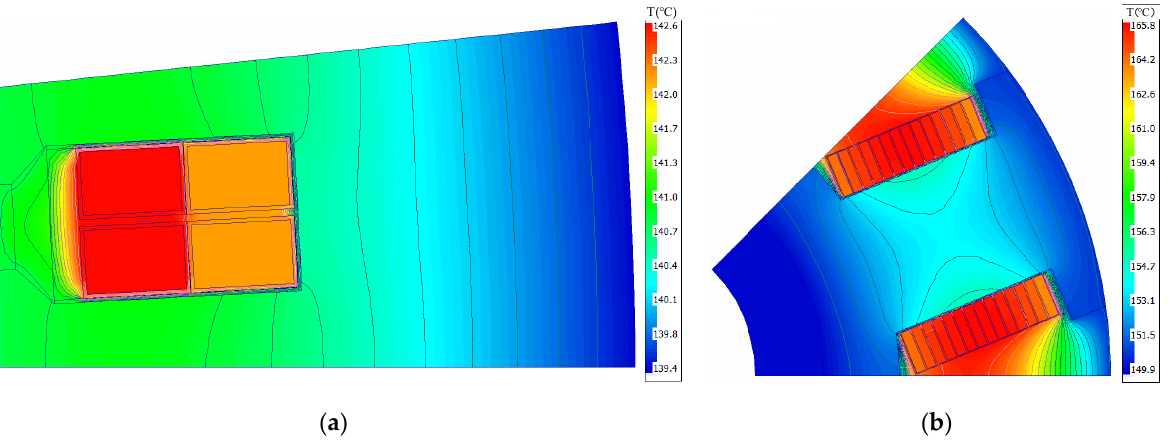
Figure 11. Generator temperature distribution during forced air cooling: ( a ) The armature winding; ( b ) The excitation winding.